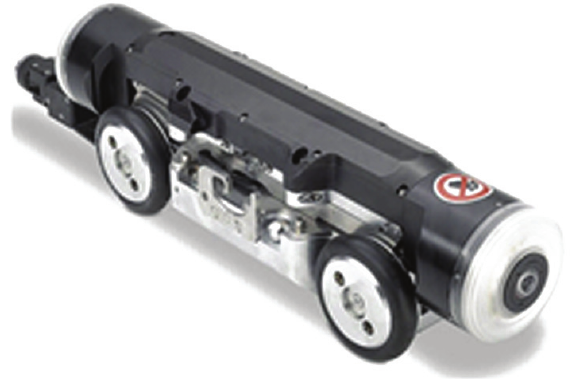
Figure 2: A commercial inspection system.